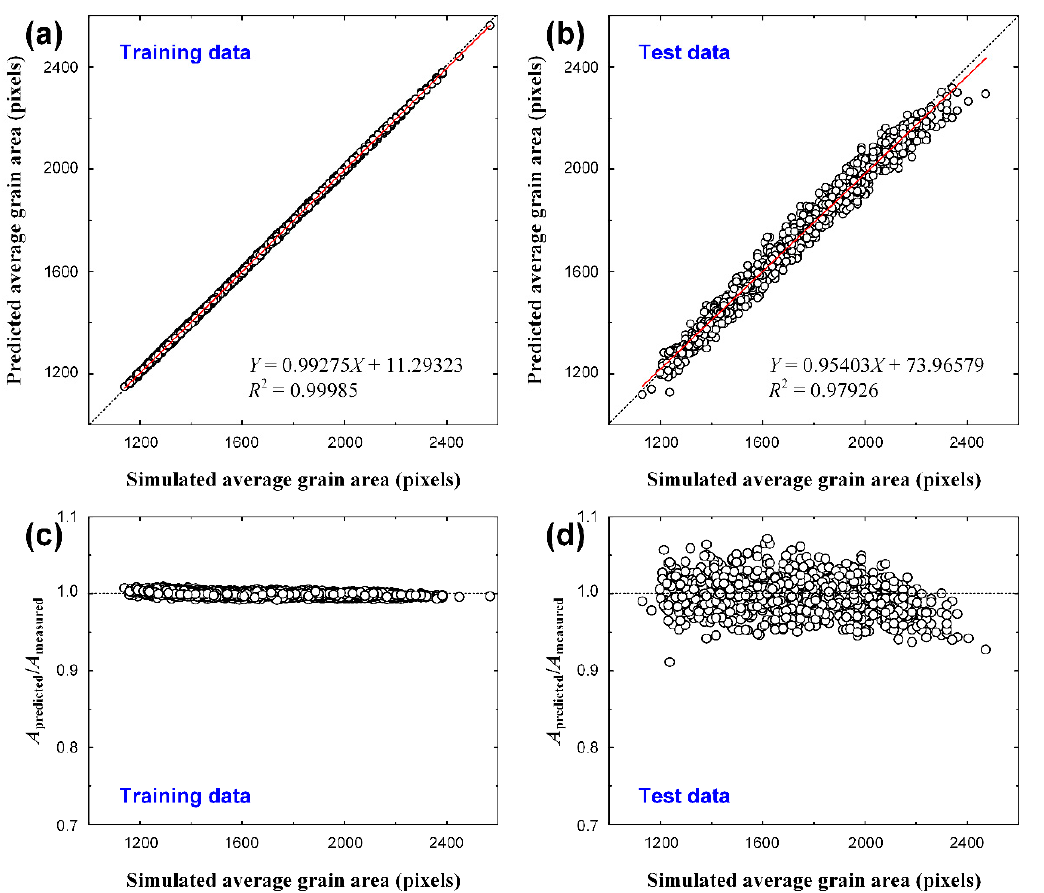
Figure 5. Comparison between the measured and predicted average grain areas for ( a ) 3000 training and ( b ) 1000 test data, and the comparison between the measured and predicted numbers of grains for ( c ) training and ( d ) test data. X and Y axes represent measured and predicted values, respectively.